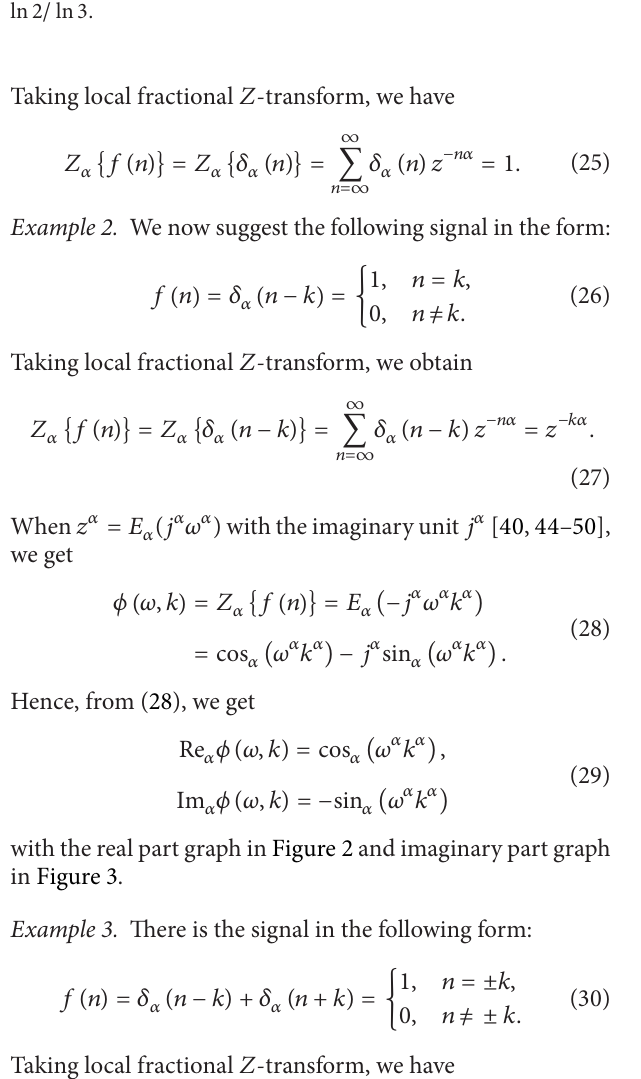
Figure 3: The plot of Im 𝛼 𝜙(𝜔,𝑘) with premasters 𝜔 = 1 and 𝛼 = ln 2/ ln 3 .